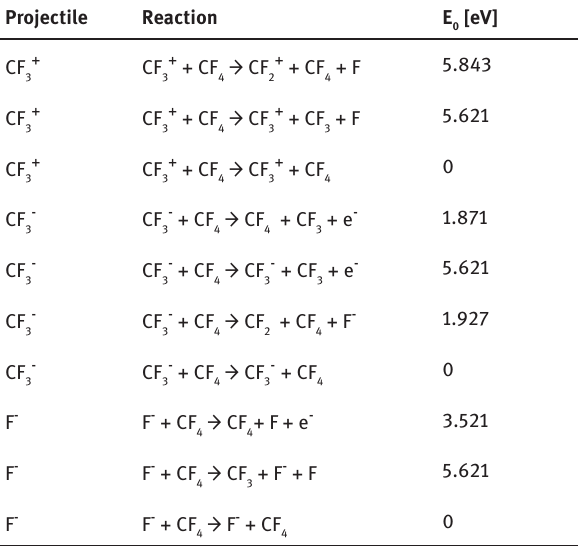
Table 2 : List of ion-CF E is the energy threshold in 0